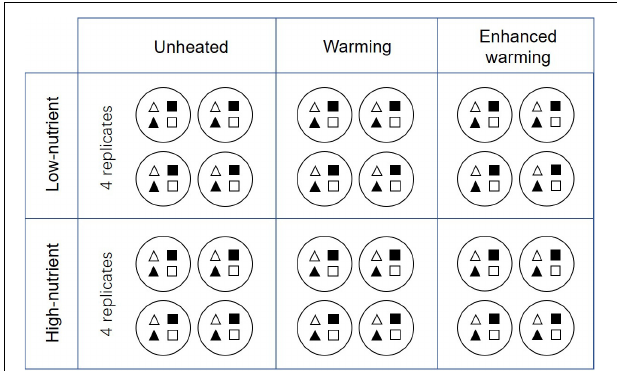
FIGURE 1 | Schematic representations of the detailed experimental design. White-triangles represent natural P. crispus ; black-triangles represent artificial P. crispus ; white-quadrilaterals represent natural E. canadensis ; black- quadrilaterals represent artificial E. canadensis . Note that the plots are grouped according to nutrient and temperature, and four plant types are listed regularly in the figure for illustrative purposes. In reality, the treatments were randomly assigned to the plots and four plant types were randomly assigned to the